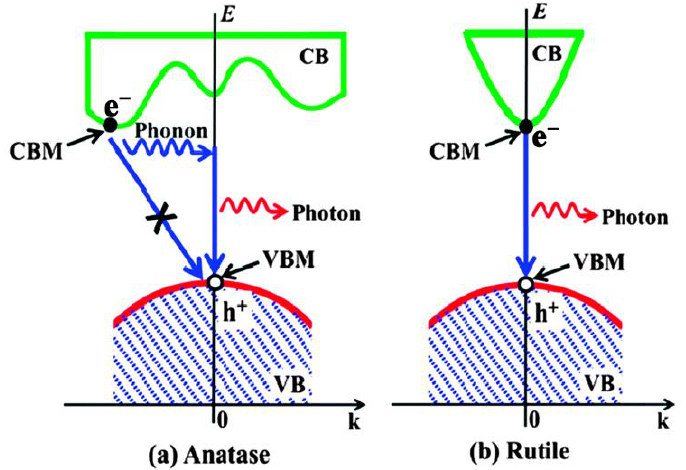
Figure 8. Schematic of recombination processes of photoexcited e − /h + pairs within ( a ) anatase TiO 2 and ( b ) rutile TiO 2 . Reprinted with permission from Ref. [174]. Copyright 2014, Royal Society of Chemistry.